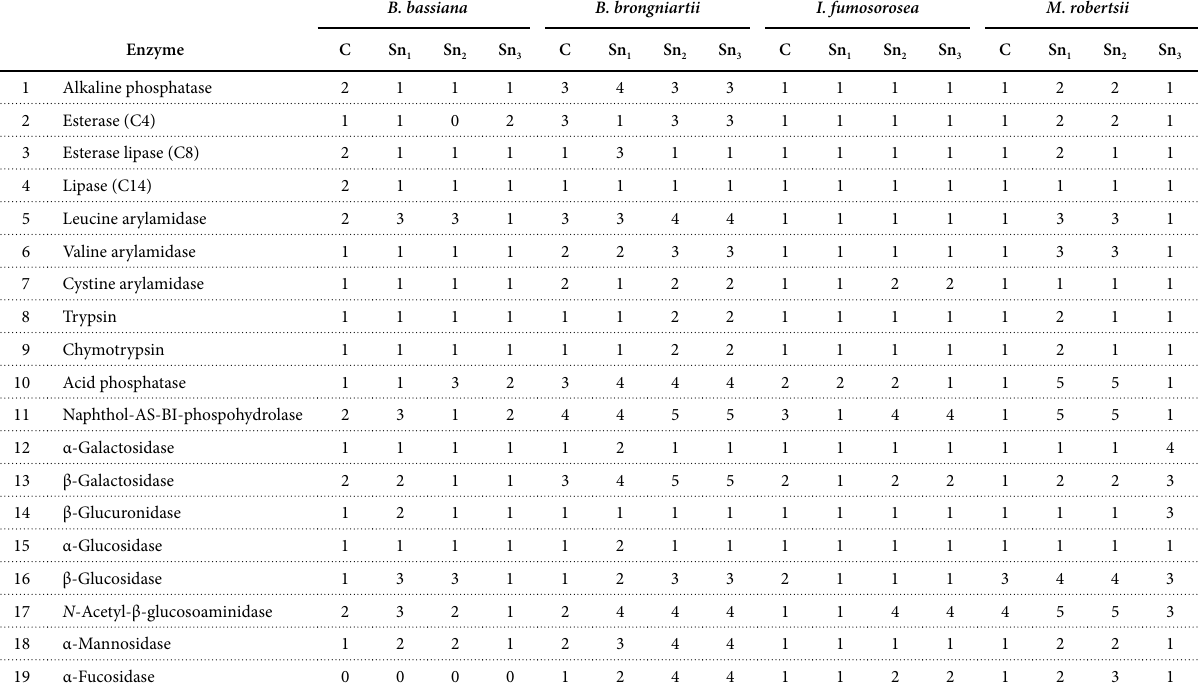
Tab. 1 The enzymatic activity of entomopathogenic fungi. Enzyme activity was determined with the API-ZYM test.